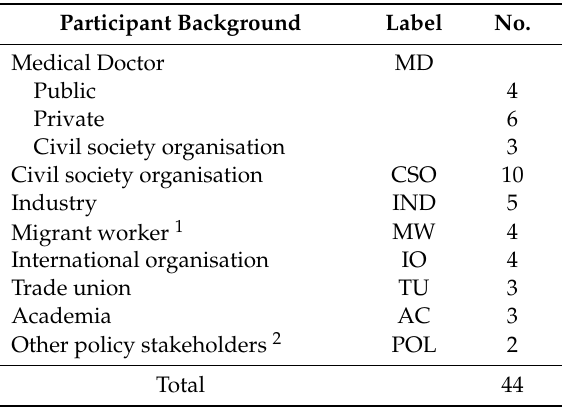
Table 1. Characteristics of the study participants ( n =